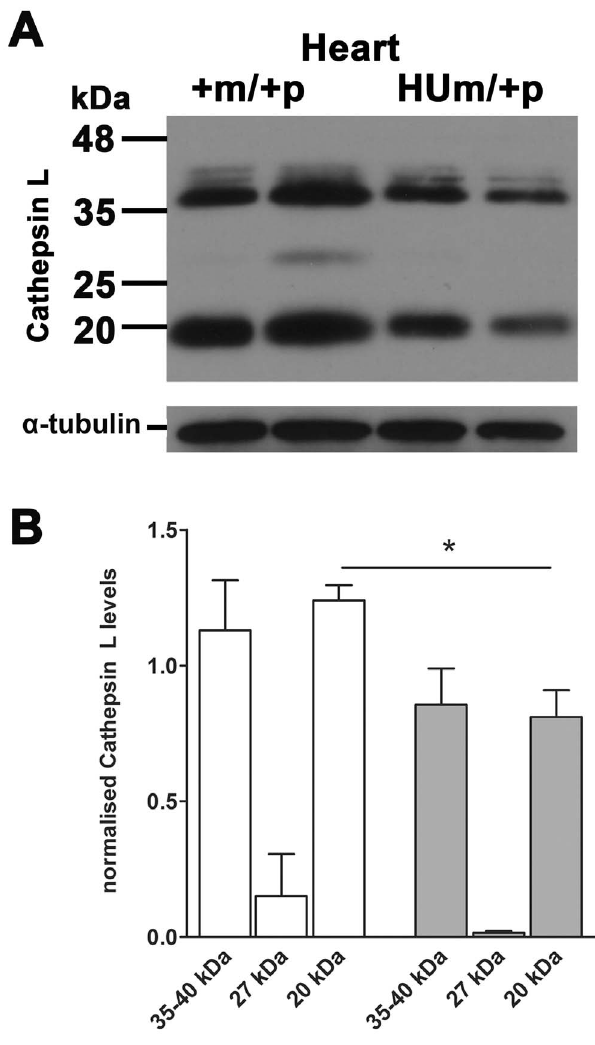
Figure 6. Embryonic heart Cathepsin L protein levels following maternal transmission of Igf2r + m/HUp ( A ) Western blots of Cathepsin L in mouse embryos at day E18.5. ( B ) Densitometry of protein levels normalised to a -tubulin loading control. Levels of cathepsin L were reduced in hearts of embryos with a humanised maternal allele (HUm) (P ,